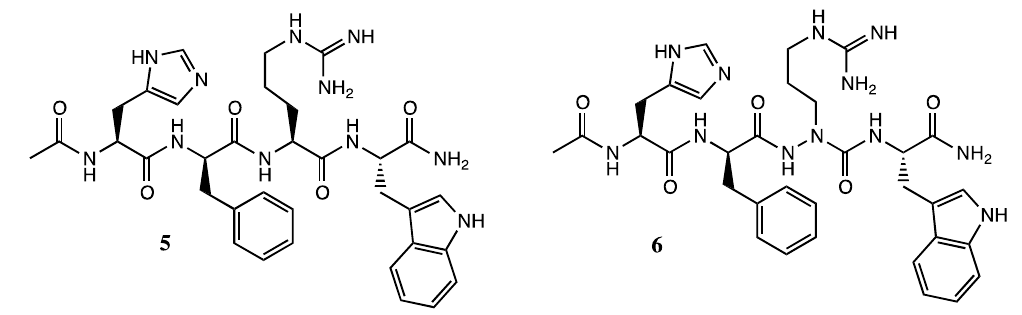
Figure 2. MSH tetra-peptide 5 and [aza-Arg 3 ]MSH analog 6